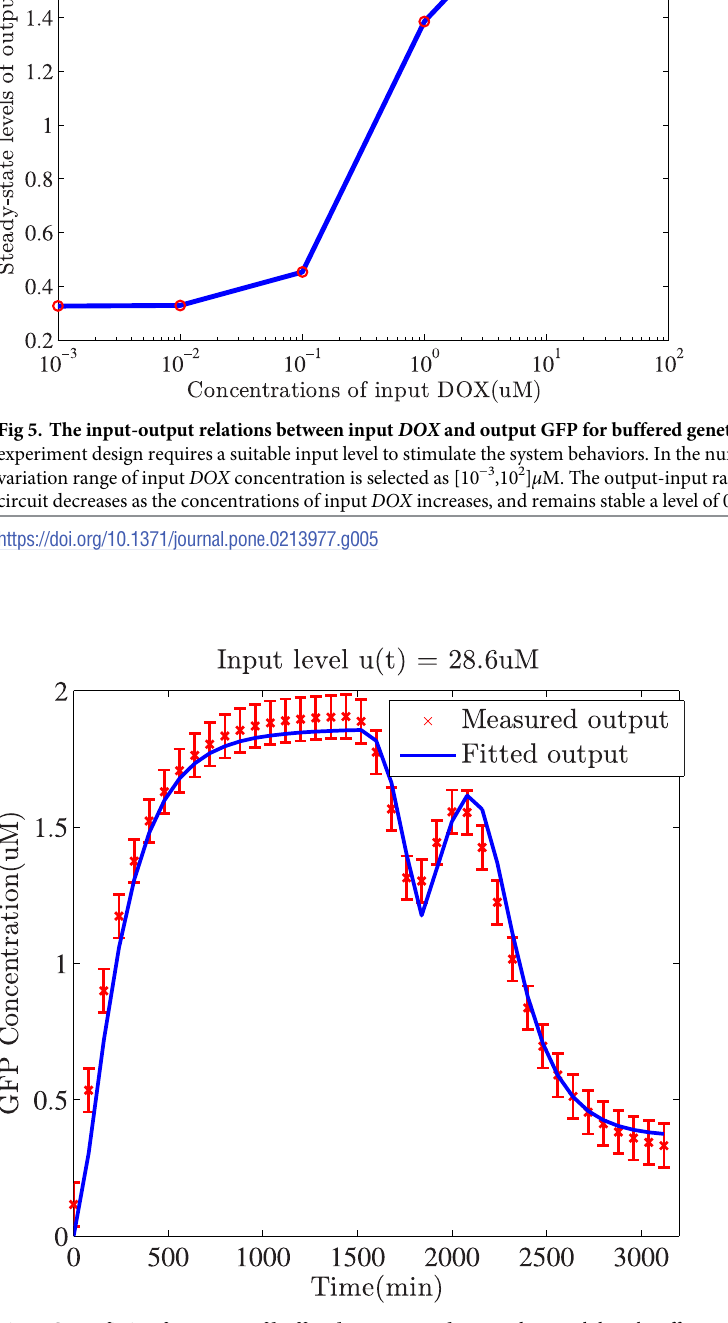
PLOS ONE | https://doi.org/10.1371/journal.pone.0213977 March 29,